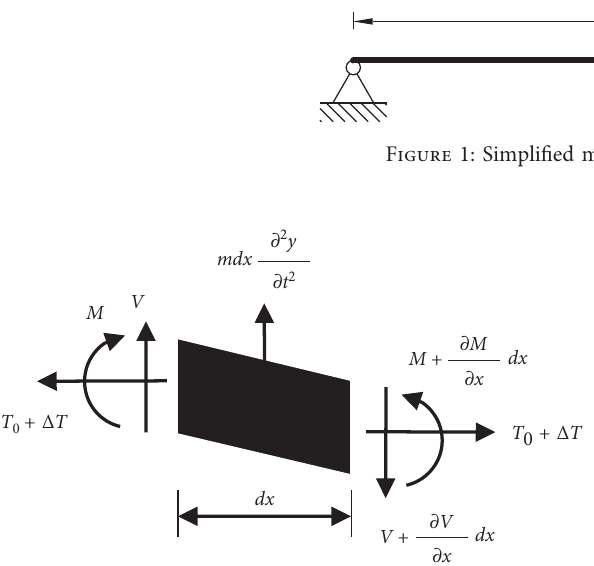
Figure 2: A microscopic mechanics model of a vertical stretched cable with consideration of bending